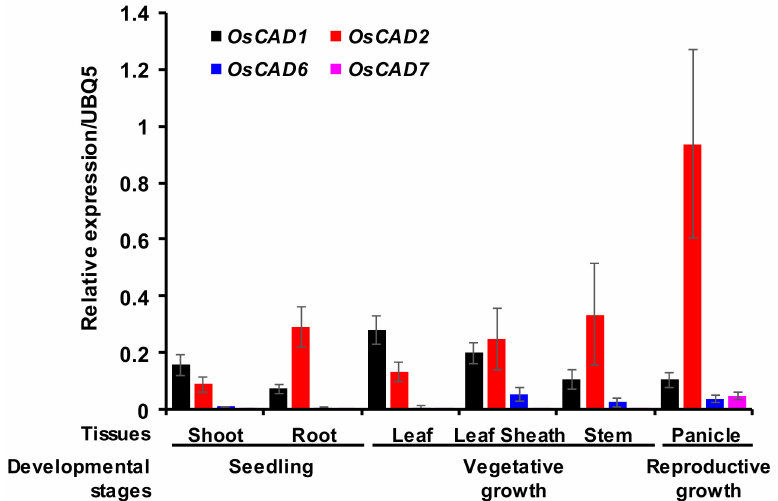
Figure 5. Expression of OsCAD1 , 2 , 6 , and 7 in rice tissues from different developmental stages. The expression levels of the OsCAD s were examined by qRT-PCR analysis using specific primers (Supplementary Table S2). A ubiquitin gene ( OsUBQ5 ) was amplified and used as an internal control. The expression levels of each OsCAD gene are presented as the relative expression compared to the OsUBQ5 transcript levels. qRT-PCR analysis was performed on triplicate biological